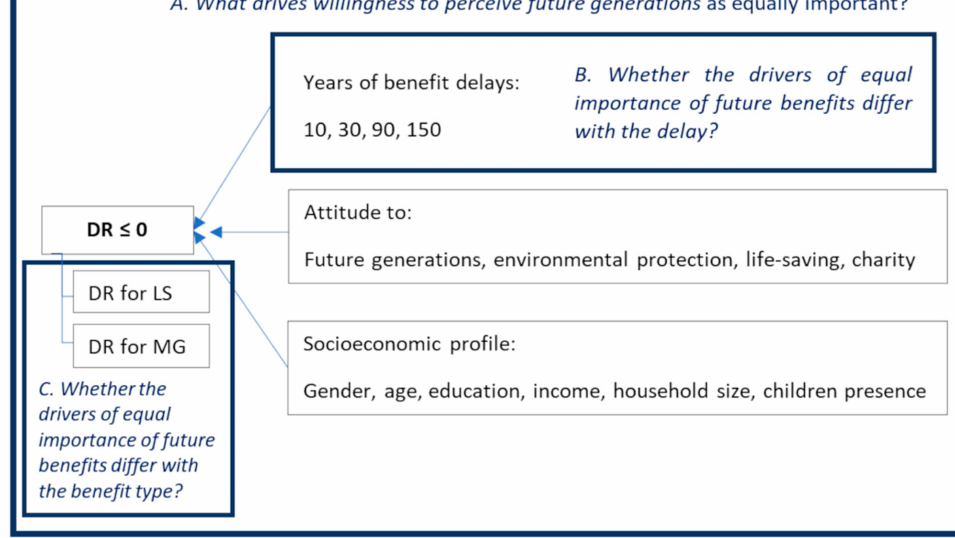
Figure 1. The conceptualization of the research